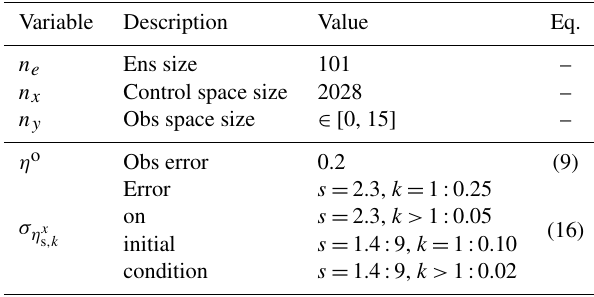
Table 1. Constant values used to generate the background control ensemble X b , the observation ensemble Y o and the model ob- e ,k e ,k ) . k is the assimilation index and s is the servation ensemble H ( X b e ,k basin zone index.